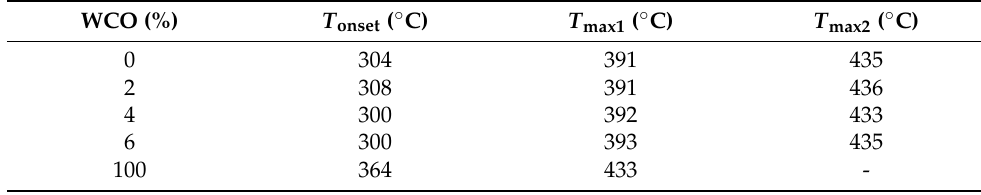
Table 1. Thermal parameters of WCO and the unmodified and WCO-modified EAR binders.